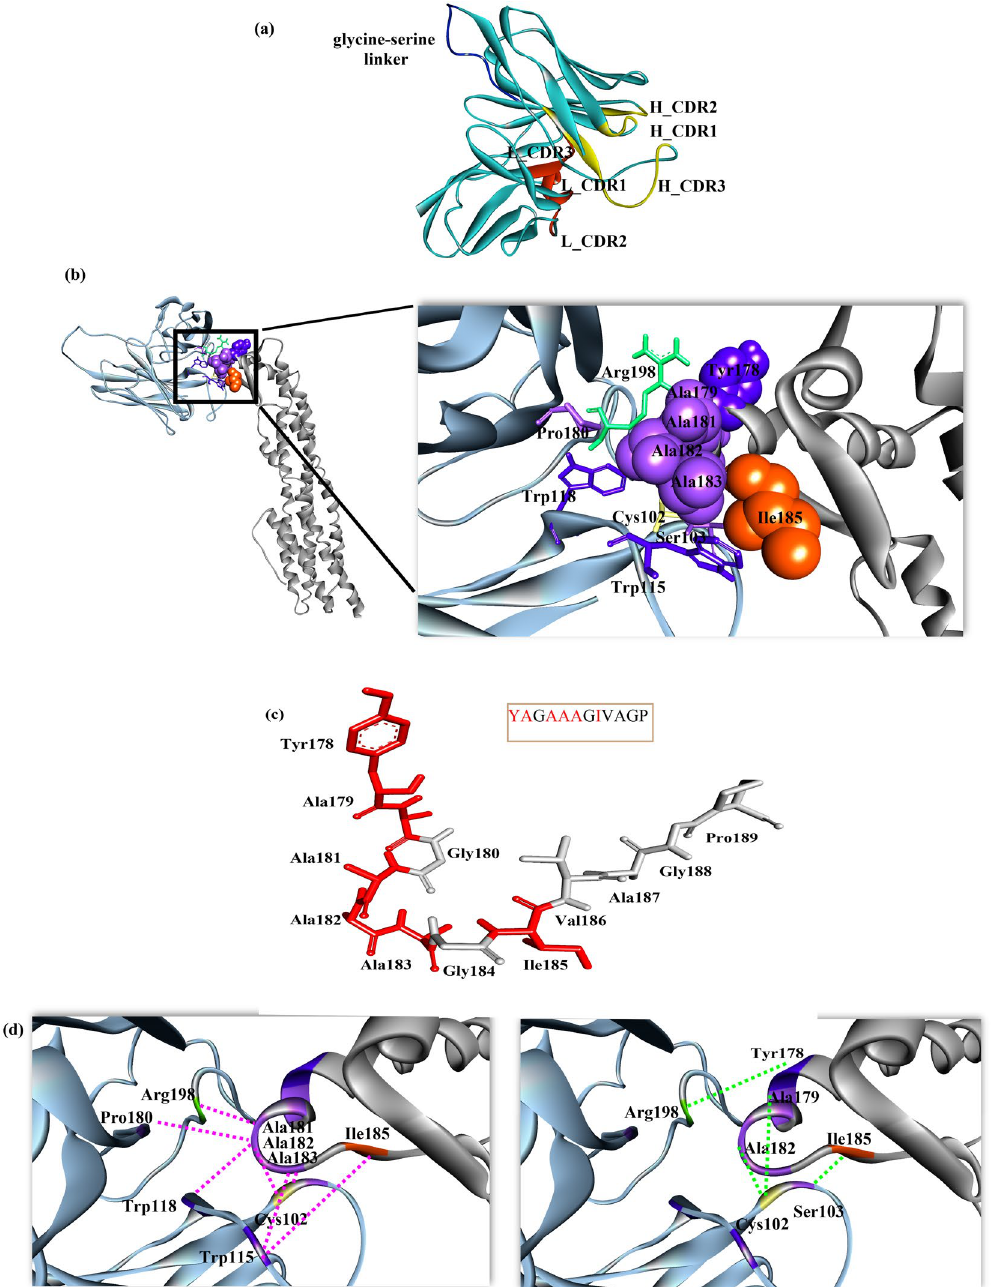
Figure 5. Structural analysis of HlyE linear epitope. ( a ) 3D model of mAb_L_A11 scFv; ( b ) docking pose of mAb_L_A11 (blue) with linear epitope of HlyE (grey) and the insight view of mAb_L_A11 (blue) binding to linear epitope of HlyE (grey). The contacting residues are in stick (paratope) and CPK (epitope) forms; ( c ) contacting residues for HlyE linear epitope with paratopes of mAb_L_A11 are highlighted in red and shown in stick format; ( d ) interaction between mAb_L_A11 (blue) with linear epitope of HlyE (grey) shown with pink and green dotted lines representing hydrophobic interaction and hydrogen bonds